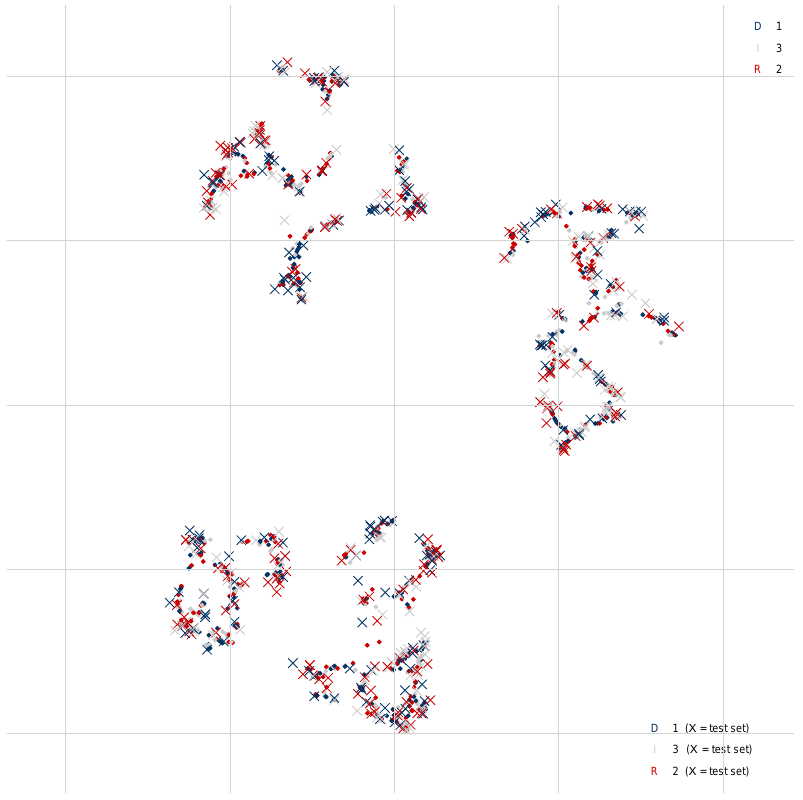
Fig. 6 Pandemic policymaking structure with random data